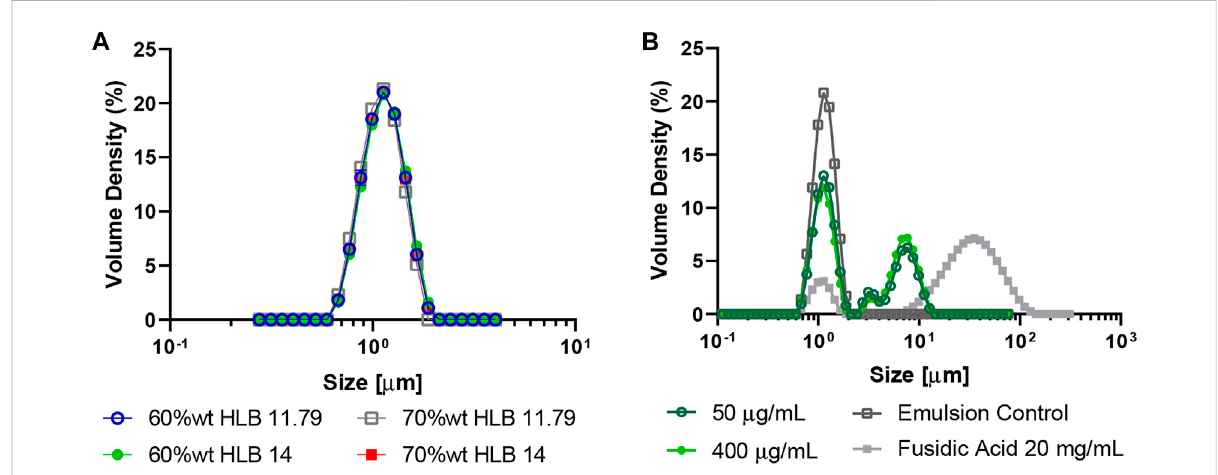
FIGURE 3 MeanhydrodynamicdiameterofO/WemulsionsasmeasuredinaMastersizer3,000instrument. (A) Emulsionsat60%wt.,70%wt.,HLBof11.79 and 14. (B) Emulsions were prepared with the MNPs- PEG8-BUF-II-Ag nanobioconjugates (50 μ g/ml and 400 μ g/ml) at 60% wt. and HLB